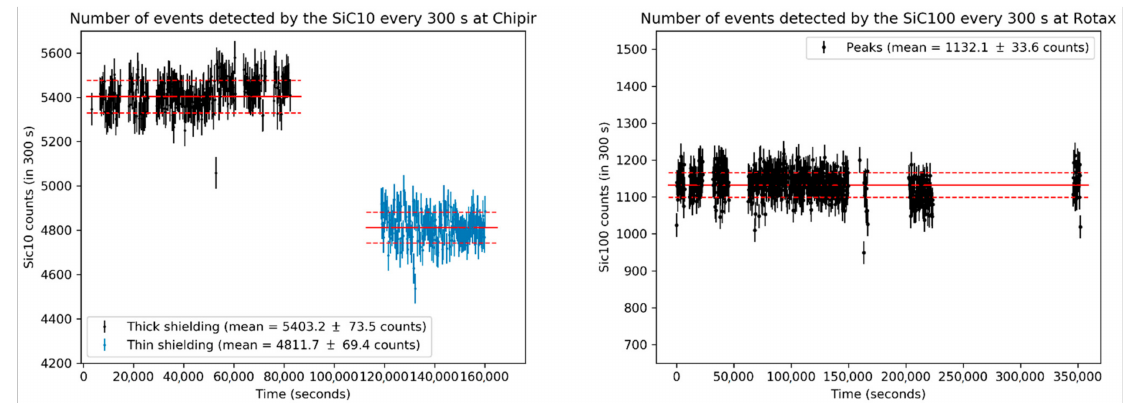
Figure 5. The numbers of events detected every 300 s by the SiC10 on ChipIr ( left ) and by the SiC100 on ROTAX ( right ) are plotted as functions of time for 44 and 98 h-long exposures, respectively. Data from the SiC10 are divided into the data taken with thick aluminum shielding (in black) and those taken with thin shielding (in blue). Red lines represent the count rates, while dashed red lines are the statistical errors for the numbers of